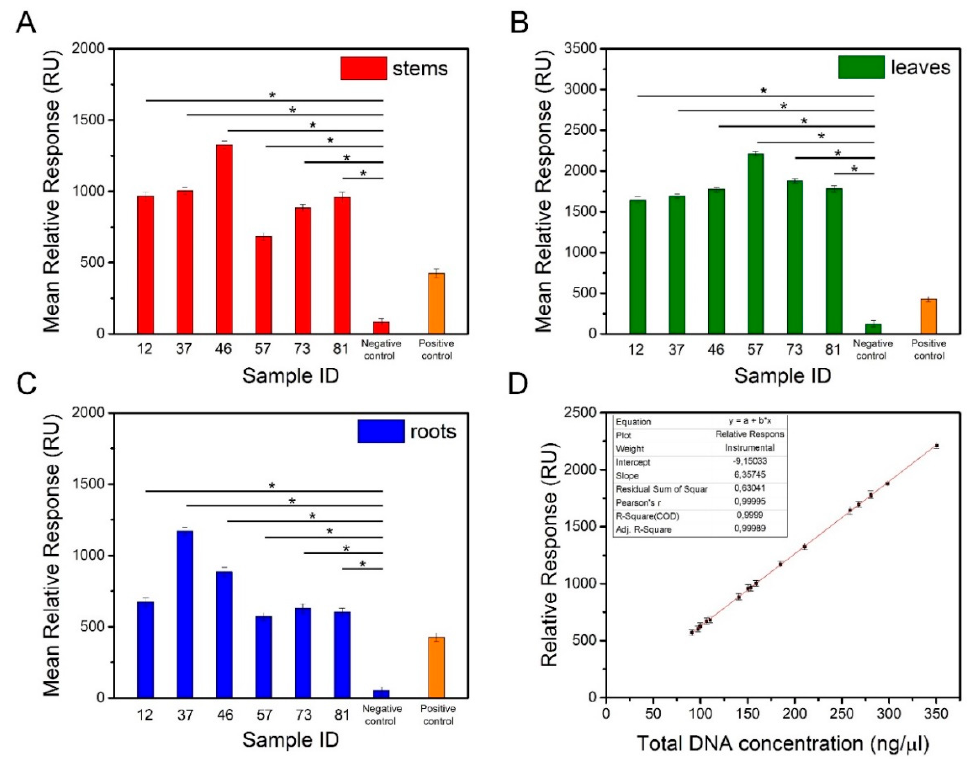
Figure 7. Mean relative responses of DNA samples isolated from the stems ( A ), leaves ( B ), and roots ( C ) of transgenic and non-transgenic tobacco. ( D ) Dependence of transgenic DNA concentration vs. relative responses.